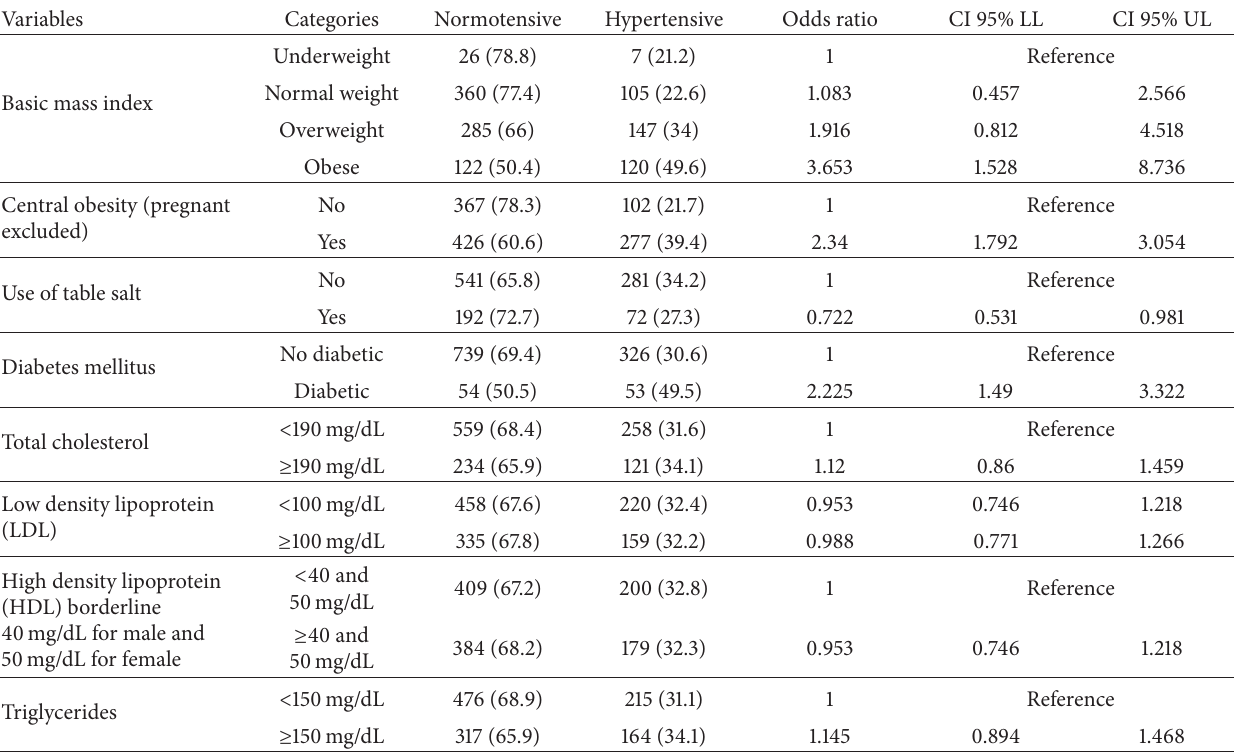
Table 4: Bivariate analysis of pathophysiologic factors and hypertension among study participants in Kabul city, Afghanistan.